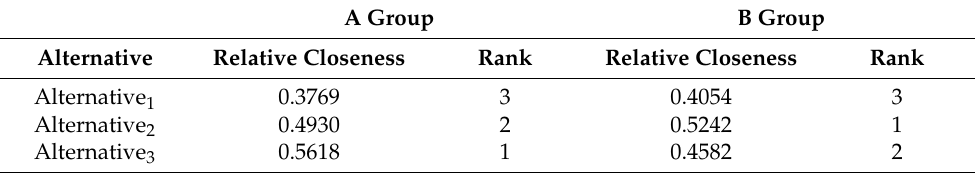
Table 8. Results from TOPSIS for both participant groups, when AIP aggregated weights were used. A Group B Group